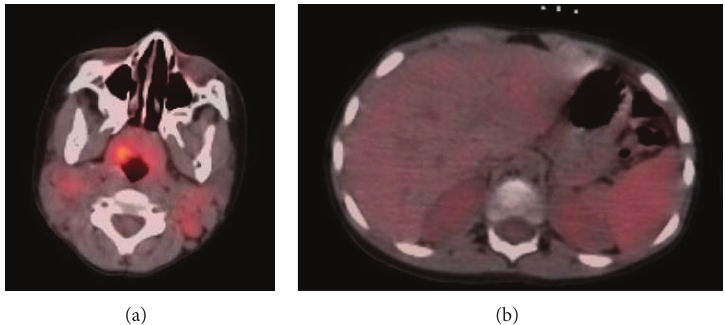
Figure 1: PET/CT demonstrates increased tracer uptake within bilateral cervical lymph nodes and the nasopharyngeal region (often normal in children). Slightly increased uptake in the spleen is seen in the image on the right with no apparent focal